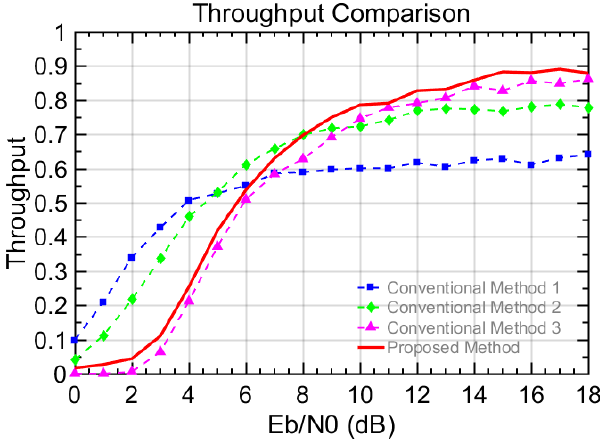
Figure 7. Throughput performance of V2V scenario II in a Rician fading channel with various K-factor values.